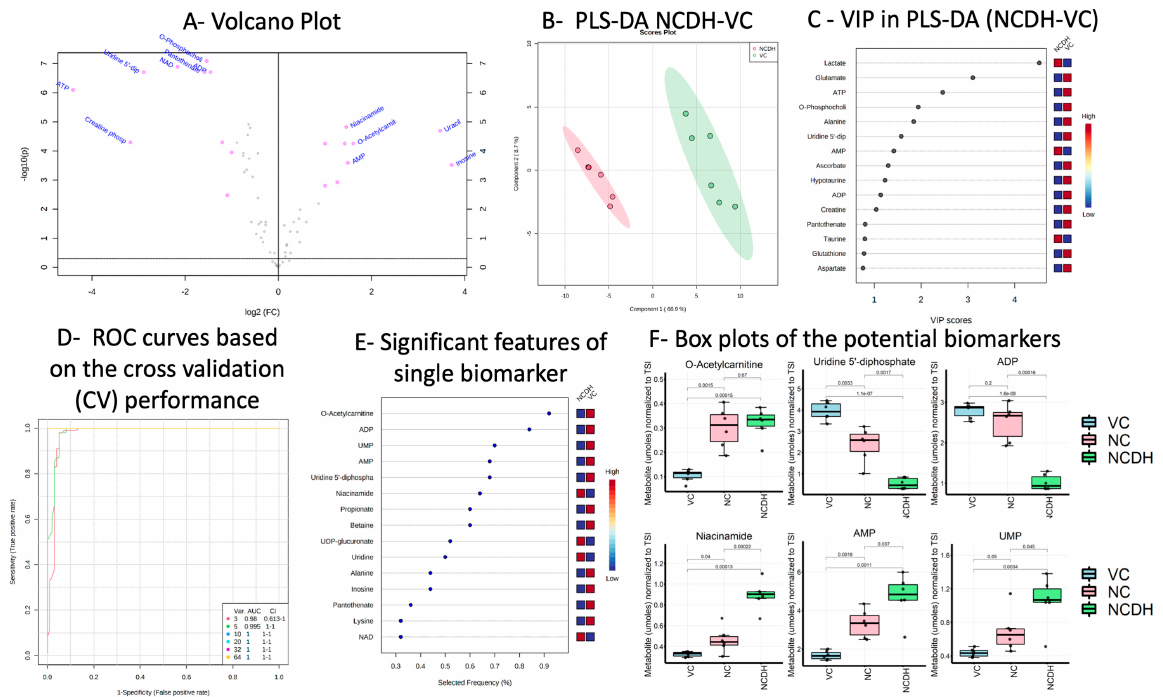
Figure 2. Comparison between NCDH-VC and biomarker analysis. ( A ) Volcano plot analysis comparing 62 metabolites between nitrofen-CDH (NCDH) and vehicle control (VC), highlighting nine increased and decreased metabolites (FC > 2.0 and p < 0.05). ( B ) Loading score plot of partial least square discriminant analysis (PLS-DA) of VC (green) and NCDH (red) with component 1 (Explained Variance (EV) 66.9%), component 2 (EV 8.7%), and 95% confidence interval, and ( C ) the corresponding PLS-DA metabolites’ variable importance in projection (VIP) from component 1. ( D ) Receiver operating characteristic (ROC) curves for the predictive models of various sets of biomarkers based on the average cross-validation performance. ( E ) The corresponding significant features of a single biomarker model ranked by importance. ( F ) Box plots of the potential biomarkers for CDH-nitrofen model with p -values based on the Student’s t -test: VC—blue, NC—red, and